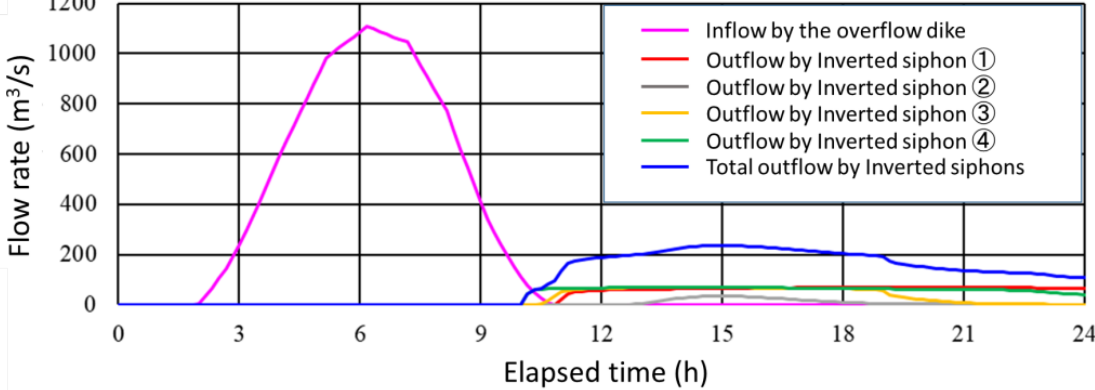
Figure 18. RWRB performance for excess flood mitigation.